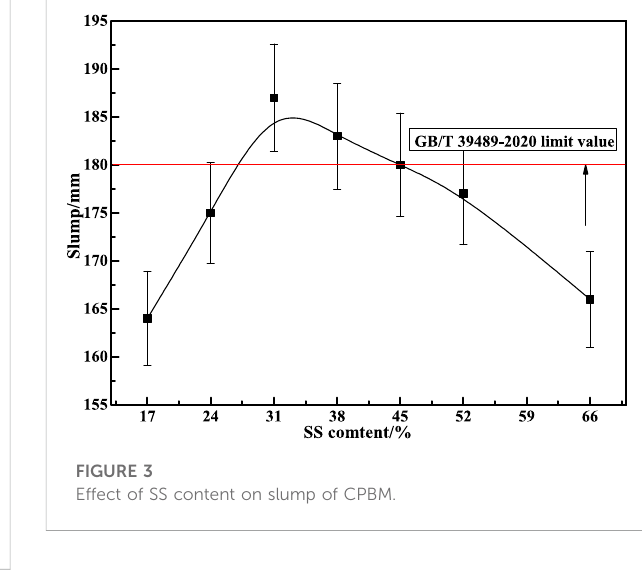
FIGURE 2 CumulativedistributionandintervaldistributioncurvesofVTIOTs at different grinding time.